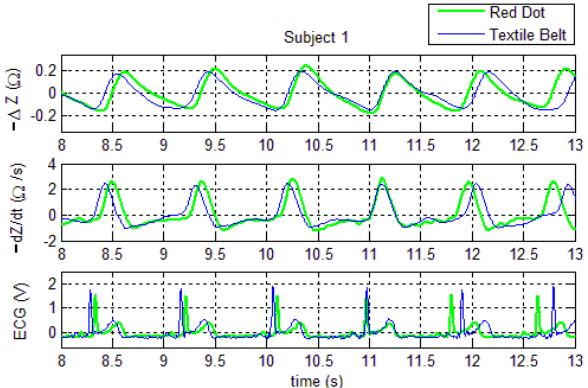
Fig. 4 ICG signals ∆ Z, -dZ/dt and ECG from Subject 1. On green trace the reference Ag/AgCl electrode and on blue trace the textile belt.